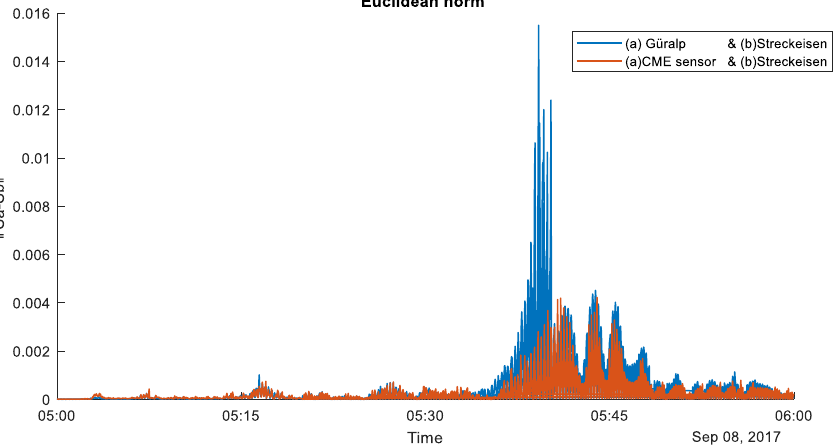
Figure 3. Comparison of records obtained by Streckeisen, Güralp, and CME devices in frequency range of 0.03–10 Hz for 8.1 magnitude earthquake in Mexico at 04:49 UT on 8 September 2017.